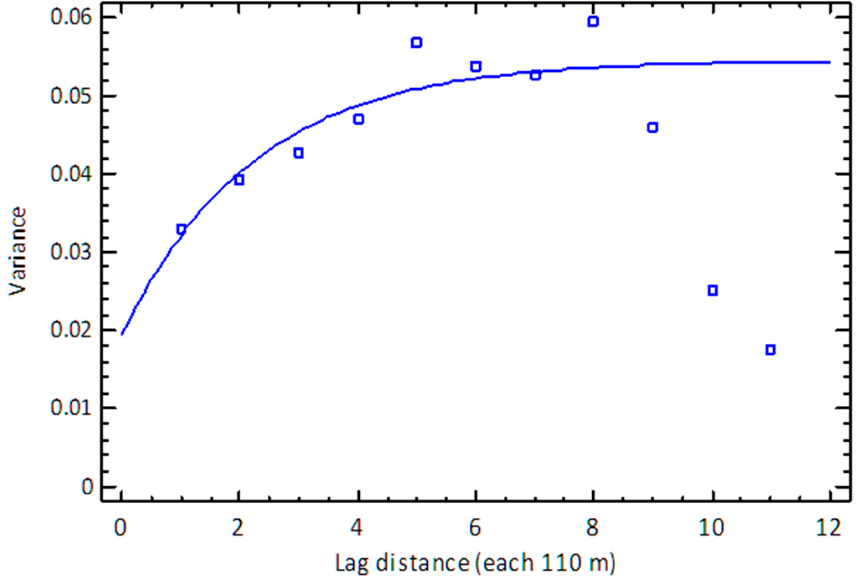
Figure 10. Exponential model fit to HS data.